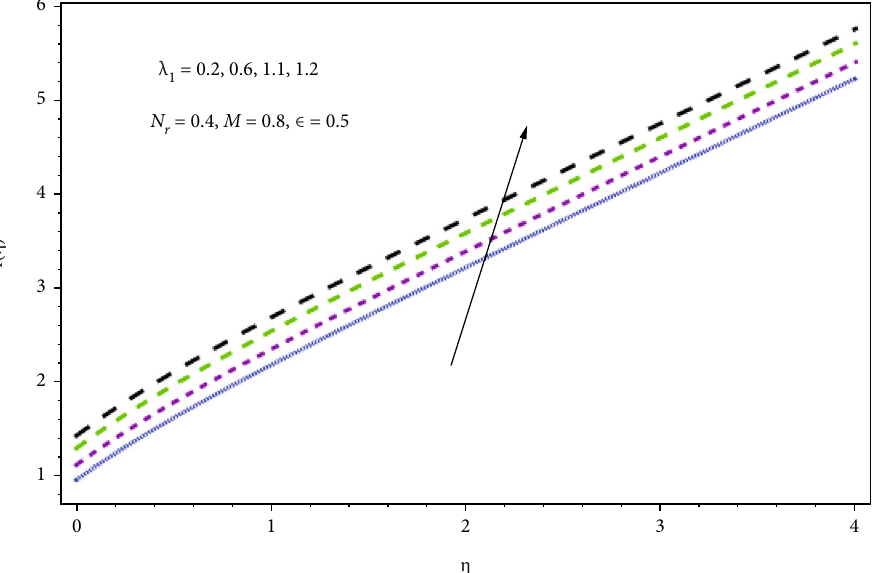
Figure 5: Illustration of the e ff ect of λ